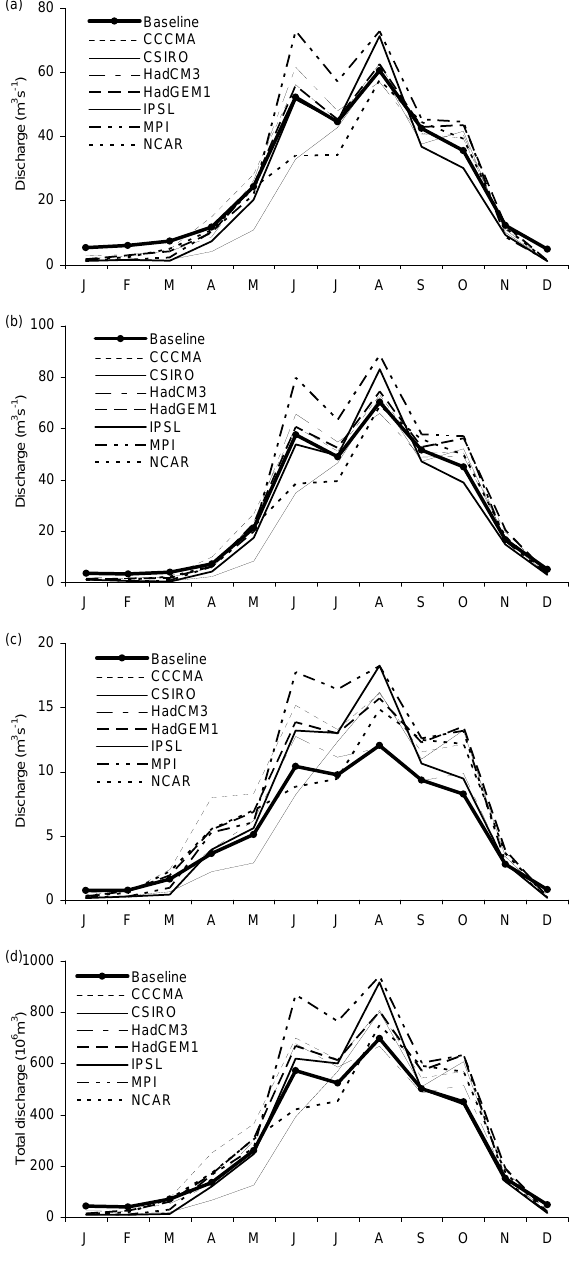
Fig. 7. Mean monthly discharge for the Group 2 scenarios (a) Thoubal, (b) Iril, (c) Nambul, (d) total river inflow to Loktak Lake.